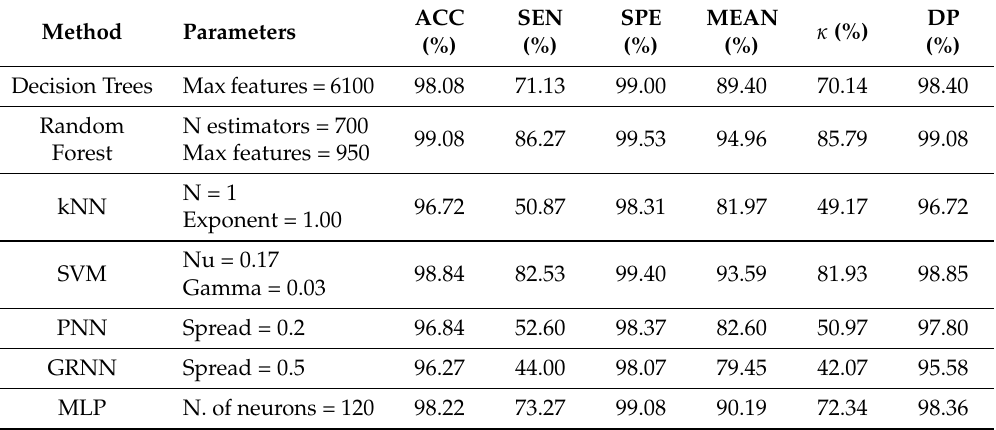
Table 4. Performance results for optimized